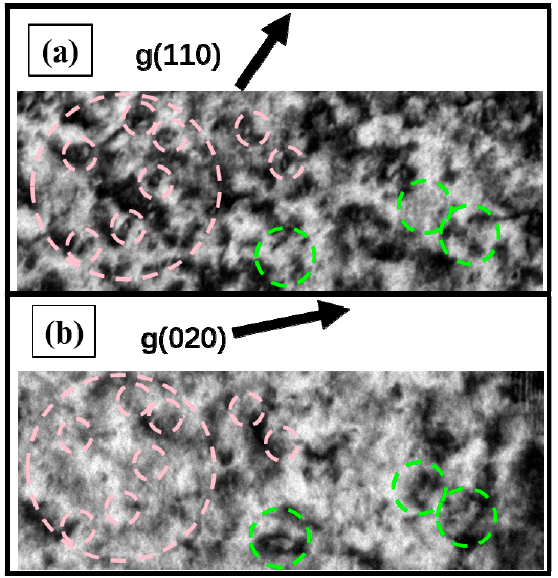
Figure 6. The same position in the A508-3 steel under two diffraction vectors, g = (020) ( a ) and g = (110) ( b ), near the [001] zone axis. The pink circle indicates that the dislocation loops are visible at g = (110), and the green circle indicates that the dislocation loops are visible at g = (020).